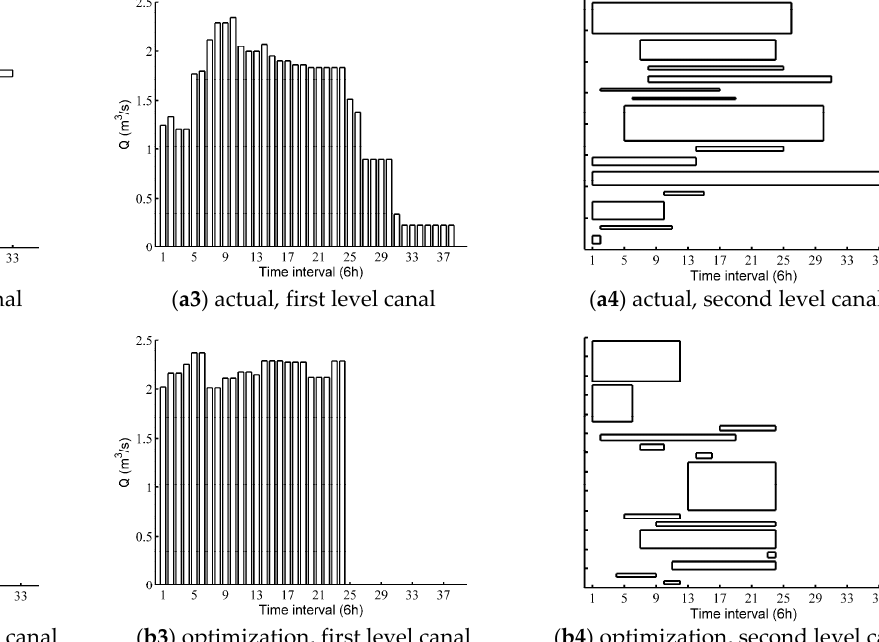
Figure 3. Comparisons of water delivery through irrigation canal systems for traditional and optimized schedules. Note: ( a1 , a2 , b1 , b2 ) represents the irrigation scheduling of branch canal No. 11 of the north canal of the Fengjiashan irrigation district; ( a3 , a4 , b3 , b4 ) represents the irrigation scheduling of the west main canal in the Shitouhe river irrigation district. In ( a2 , b2 ), from bottom to top, each rectangle successively represents the water delivery discharge and duration from the second-level canal numbered 1 to 24; ( a4 , b4 ) are numbered 1 to 14; the height of each rectangle represents the value of discharge and the length represents the duration of water delivery; the scale of the vertical axis is 0.2 m 3 /s in ( a2 , b2 ) and 0.4 m 3 /s in ( a4 , b4 ).